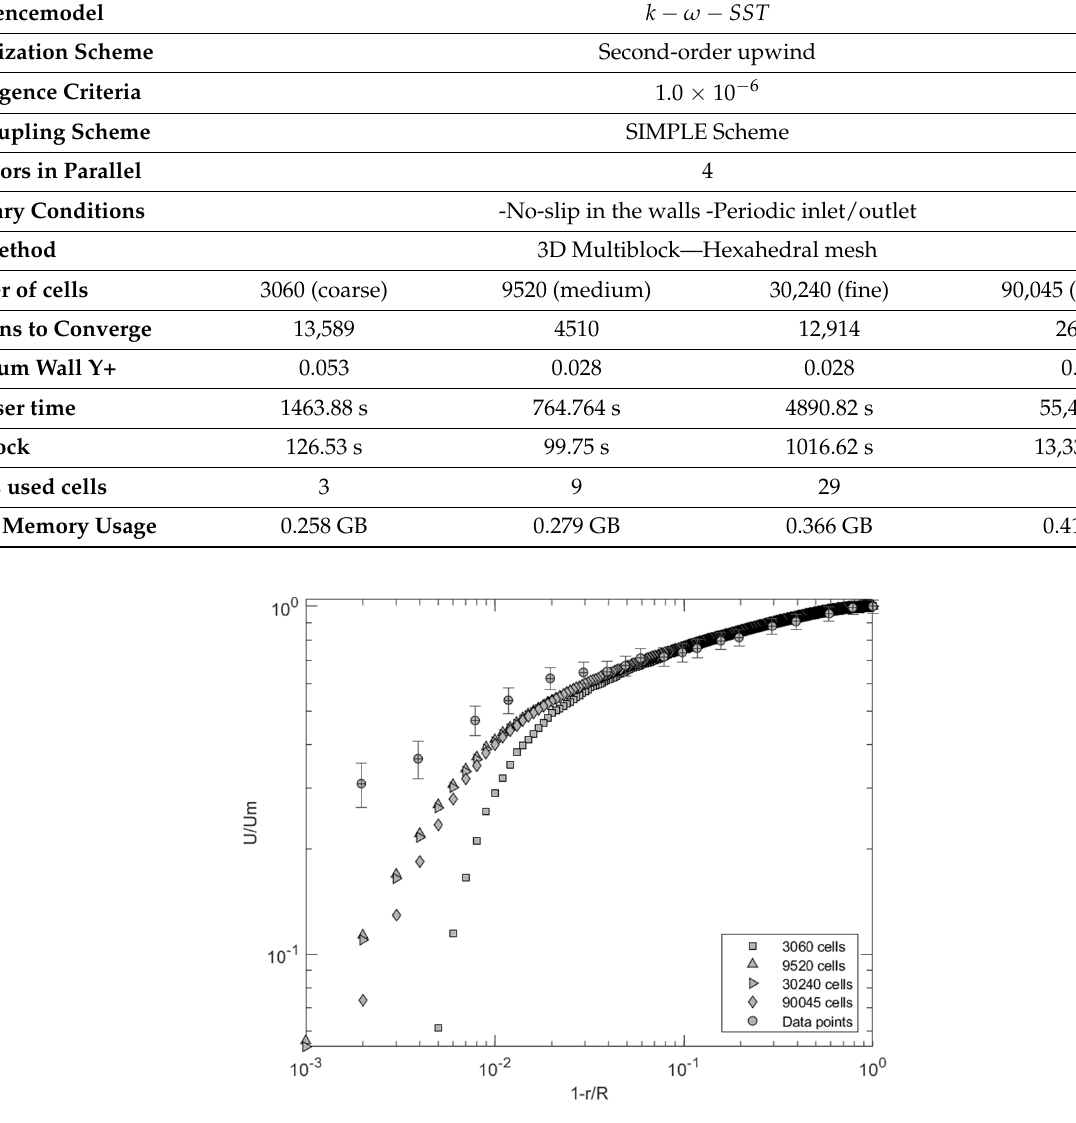
Figure 6. Comparison of the normalized velocity profile for different mesh resolution plotted in log- log scale. log-log